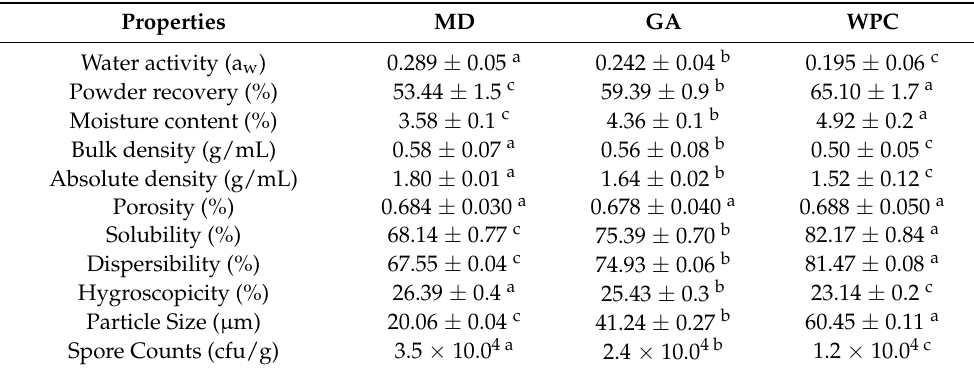
Table 3. Physicochemical and microbiological analysis parameters of spray dried nutritionally rich honey powders fortified with maltodextrin (MD), gum arabic (GA), and whey protein concentrate (WPC) carrier